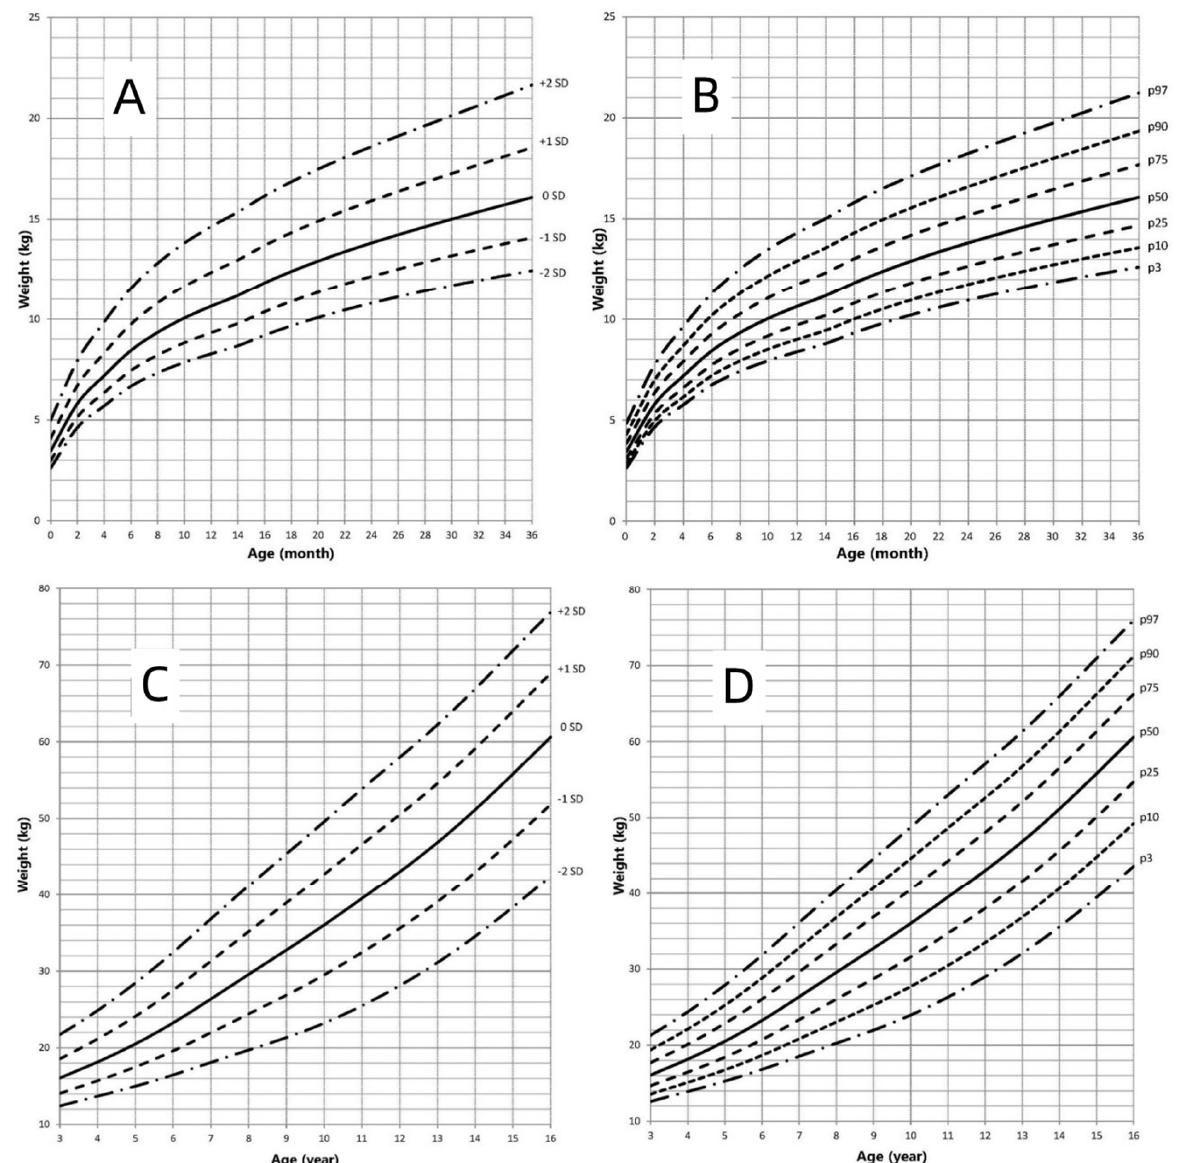
Figure 4. Weight in children with AIS (0–16 years old). ( A ): Standard deviation curve (0–36 months old); ( B ): Percentile curve (0–36 months old); ( C ): Standard deviation curve (3–16 years old); ( D ): Percentile curve (3–16 years old).